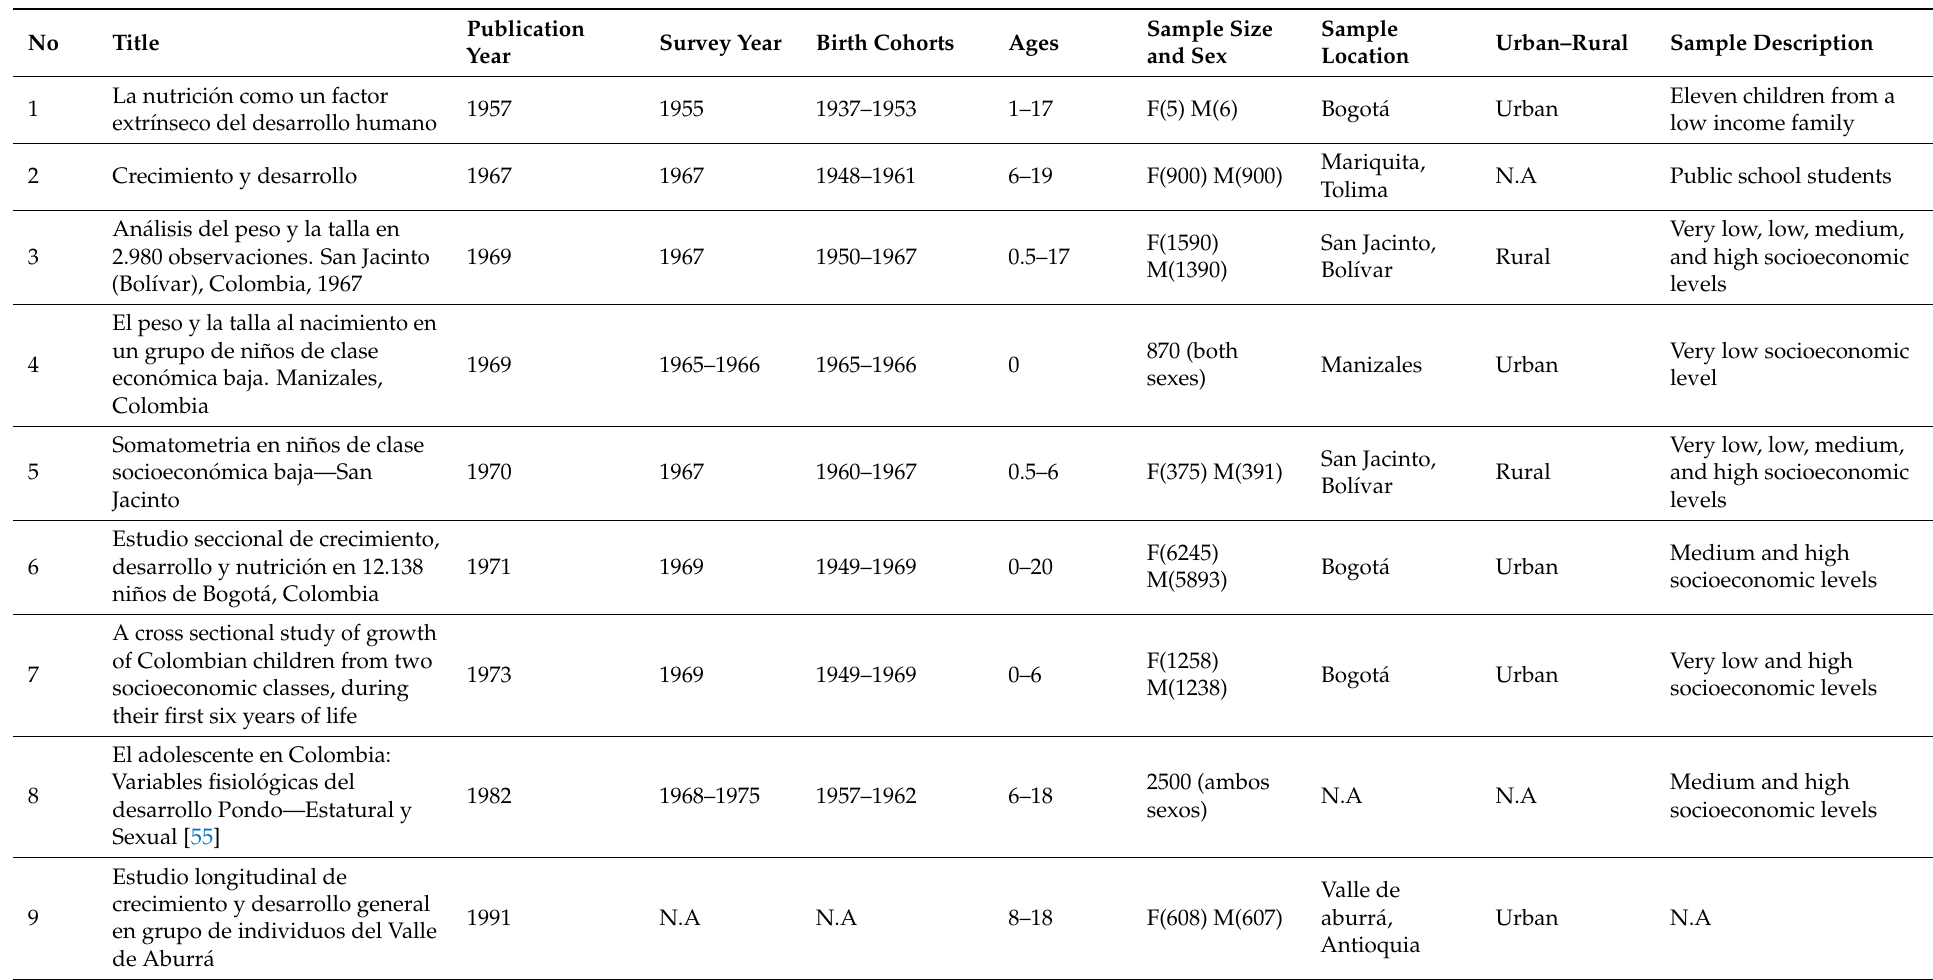
Table A1. Description of the 37 studies about the heights of children and adolescents in Colombia,